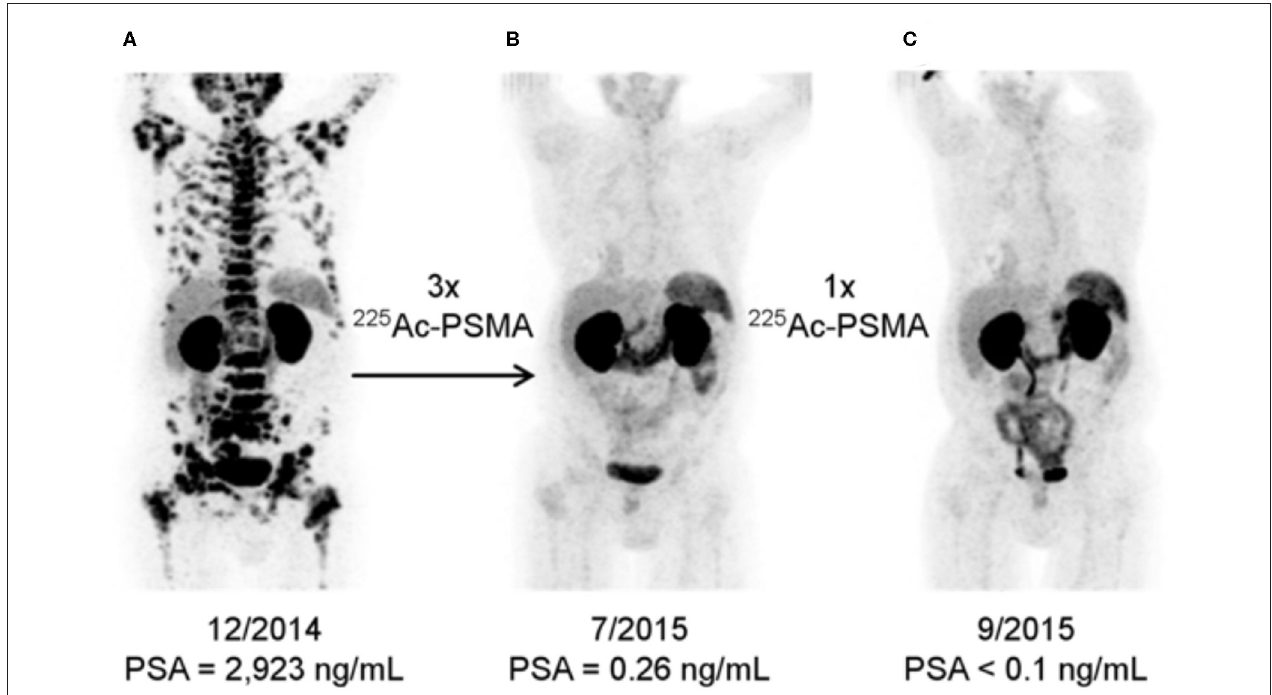
FIGURE 5 | [ 68 Ga]PSMA-11 Imaging Response to [ 225 Ac]PSMA-617. Alpha-particle emitting Ac-225 bound to the DOTA chelator-bearing PSMA-617 scaffold was used to treat a patient following disease progression after several lines of conventional treatment and [ 177 Lu]PSMA-617. Serial images during the treatment course reveal significantly less PSMA expression and potential lesion eradication. A decrease in salivary gland uptake is also noted, as it is a site of PSMA expression inadvertently treated by these agents. Reproduced from